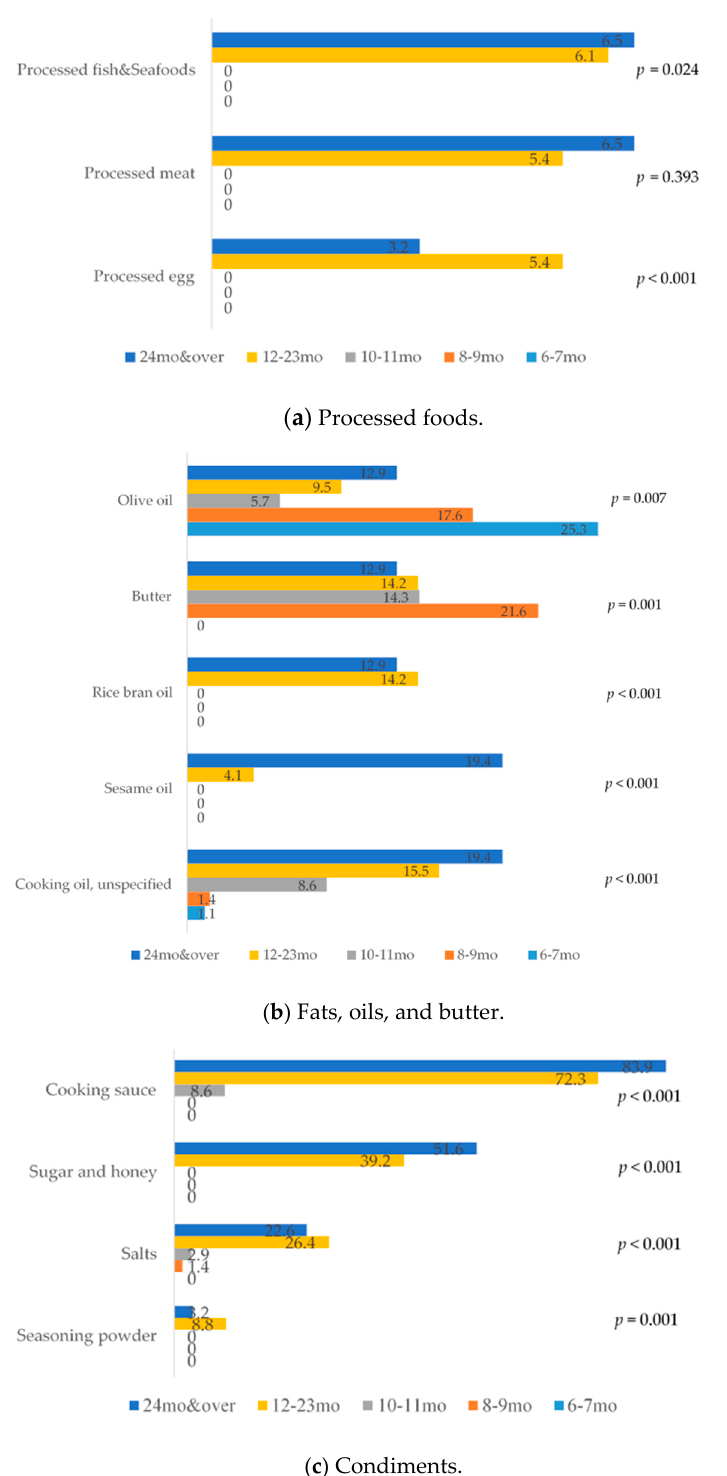
Figure 3. Percentage of ingredients used in shared recipes across children’s age groups